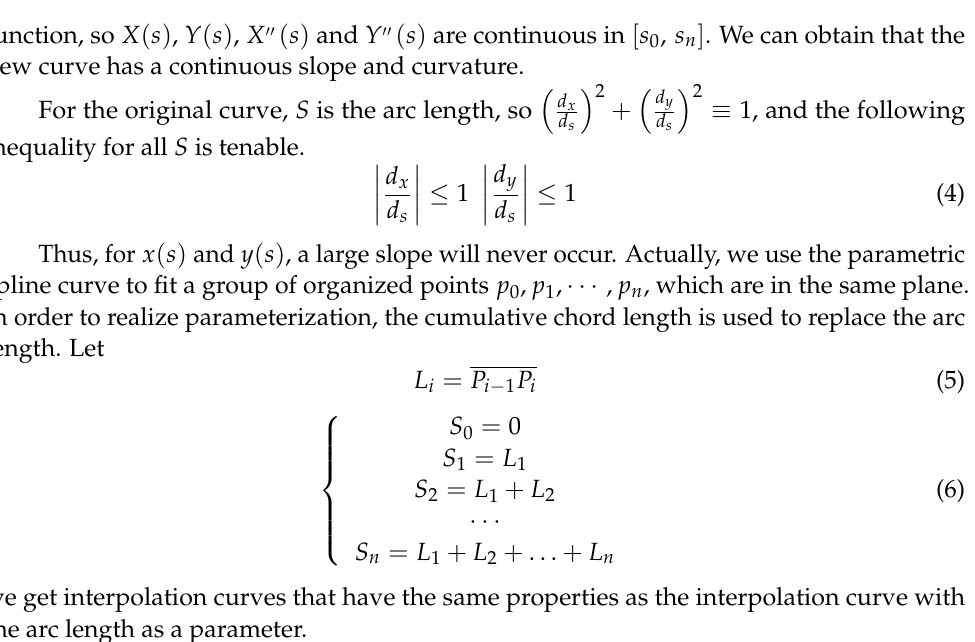
corresponding point on each roll pass curve and form n curves f 1 , f 2 , f 3 , · · · , f n .